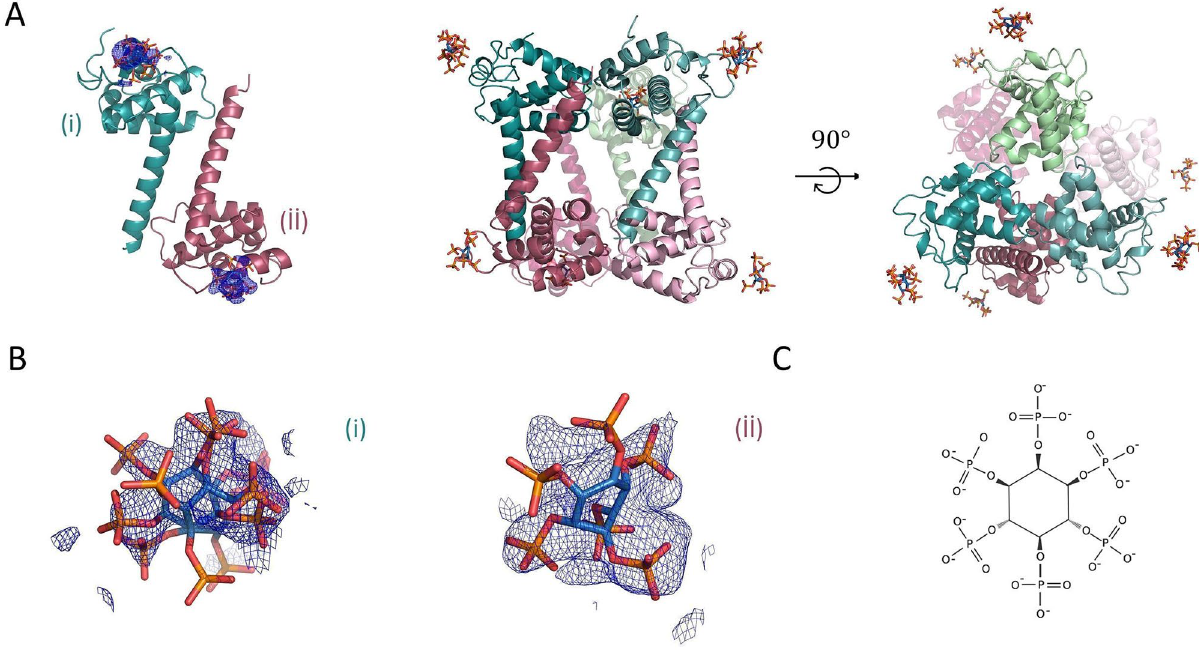
Figure 1. The overall structure of MA_IP6_R32 with symmetric units. ( a ) Chains A and B of MA_IP6_R32 structure in the asymmetric unit cell are colored in deep-teal and raspberry, respectively. Chain A and B symmetry mates are generated in PyMOL and are colored in pale green and light pink for the representation of symmetric units, respectively. Carbon, oxygen and phosphorus atoms of IP6 molecules are colored by sky blue, red and orange, respectively. ( b ) 2 F o- F c simulated annealing-omit map is colored in blue mesh and shown at 2.5σ level within 5.0 Å from IP6. ( c ) Chemical structure representation of the myo -IP6